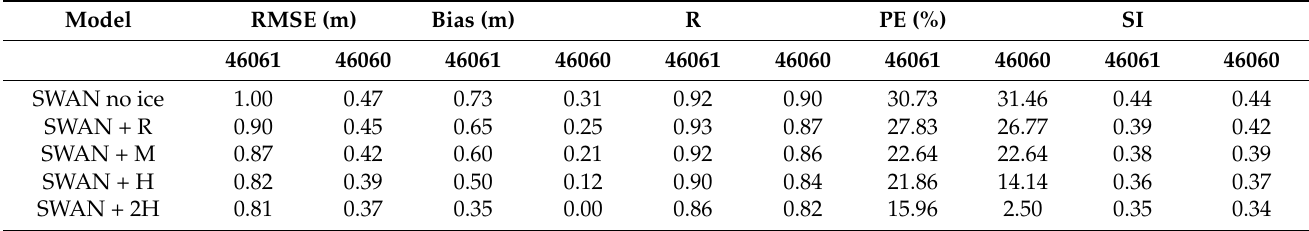
Figure 6. Modeled versus measured significant wave heights, H s , at buoy 46061 ( a – e ) and 46060 ( f – j ) for increasing amounts of sea ice concentration (SIC). Sea ice concentrations were calculated from AMSR2 data at the mouth of PWS. The gray line is the one-to-one line, the orange line is the linear regression of the SWAN only model to the buoy data, and the black line is the linear regression of the SWAN model with ice to the buoy data. Table 3. SWAN model performance with no ice and four sets of ice coefficients during December 2017. The coefficients are listed from the smallest (0 for no ice) to the largest ( 2H